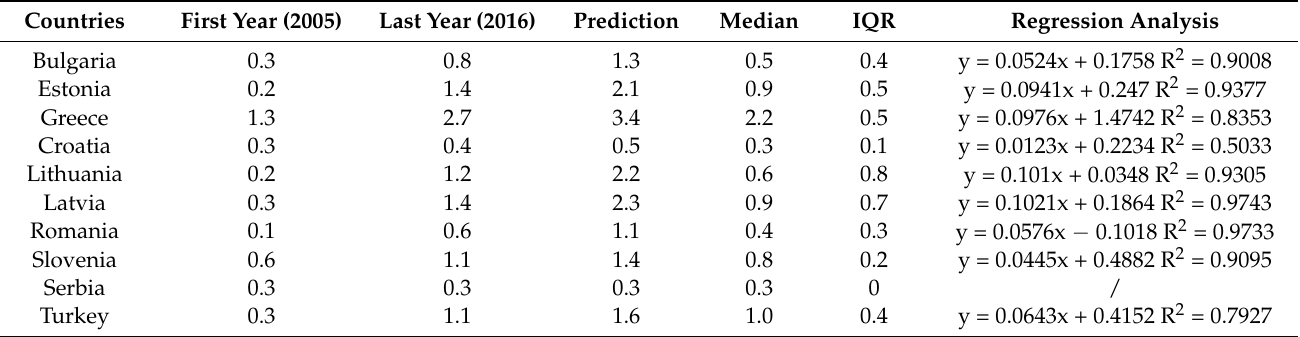
Table 6. Values of total number of magnetic resonance units per 100,000 inhabitants—value of the first observed year, last observed year, predictive value, median value, inter-incremental difference and linear regression